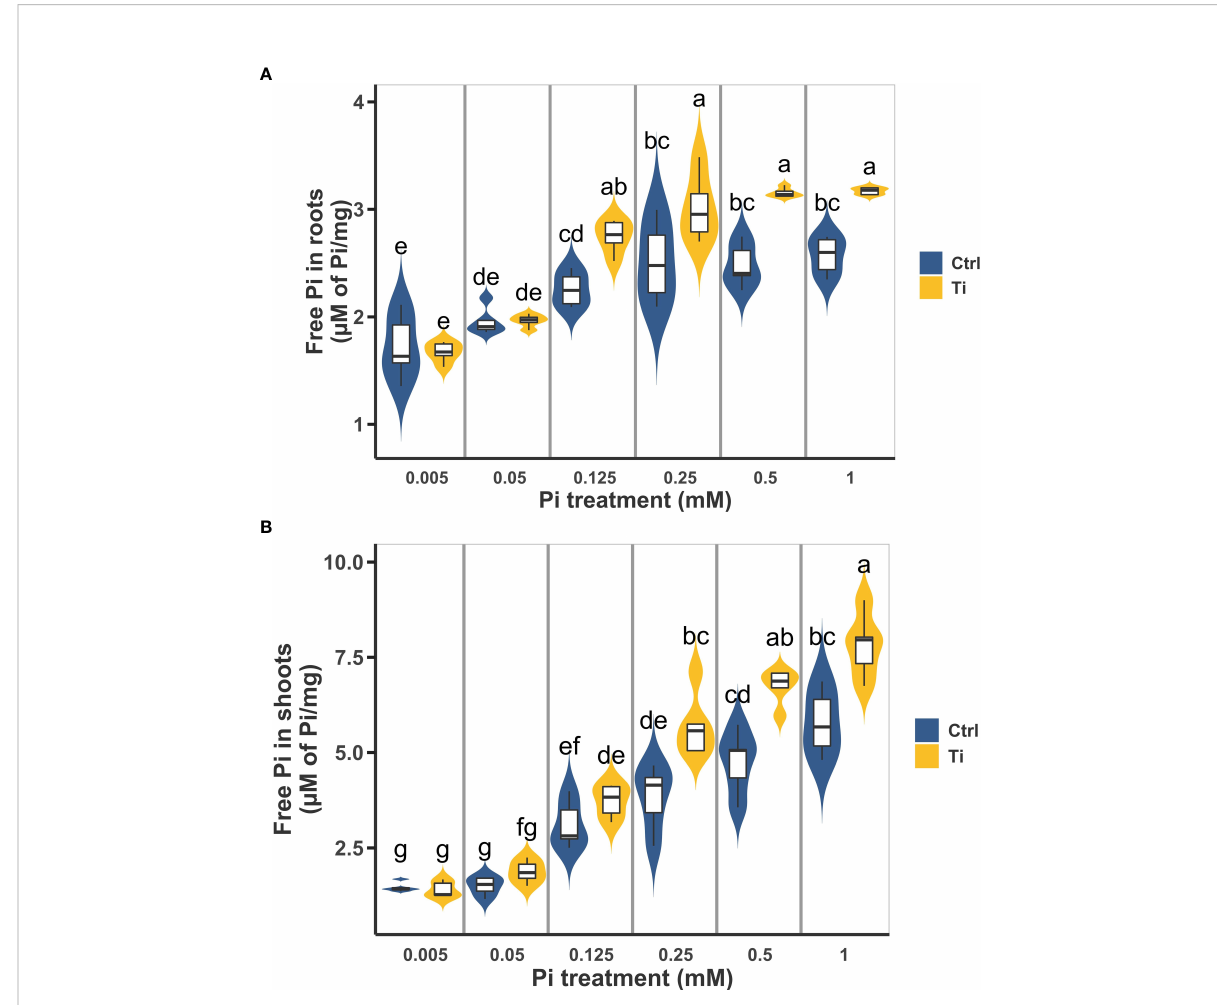
FIGURE 2 Effect of Titanium (Ti) on Arabidopsis inorganic phosphate (Pi) content under variable Pi conditions. Arabidopsis seedlings were grown under 0.005, 0.05, 0.125, 0.5, and 1 mM Pi and treated with Ti 2 mM. Free Pi content was determined in root (A) and shoot (B) after ten days of germination. No added Ti was used as control treatment. Different letters indicate statistically signi fi cant differences according to Tukey ’ s signi fi cance test (p<